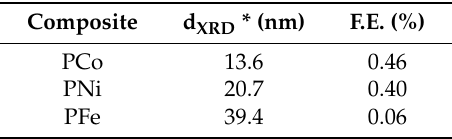
Table 4. Mean crystal particle size (d XRD ), and apparent faradaic efficiencies (F.E.) for the electro-catalytic